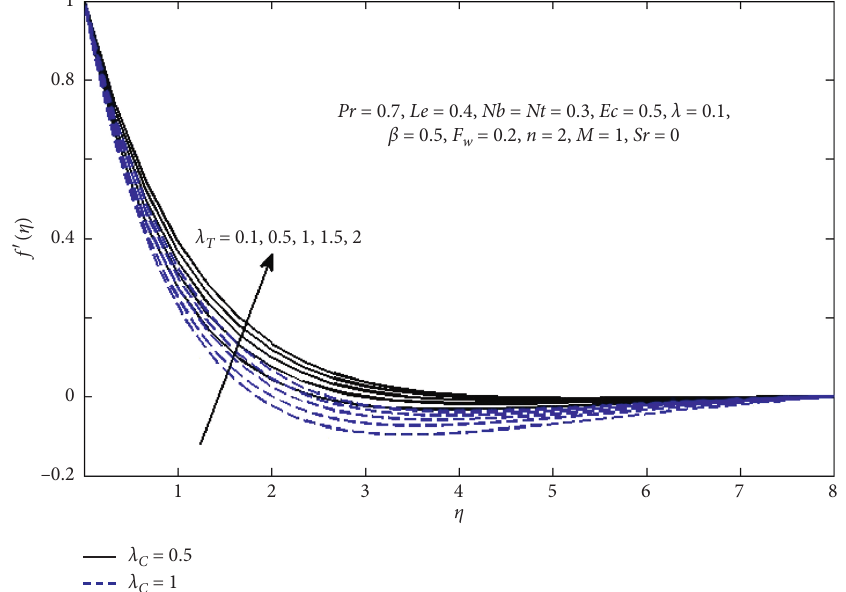
Figure 8: Diversity of velocity f ′ concerning η with various values of λ